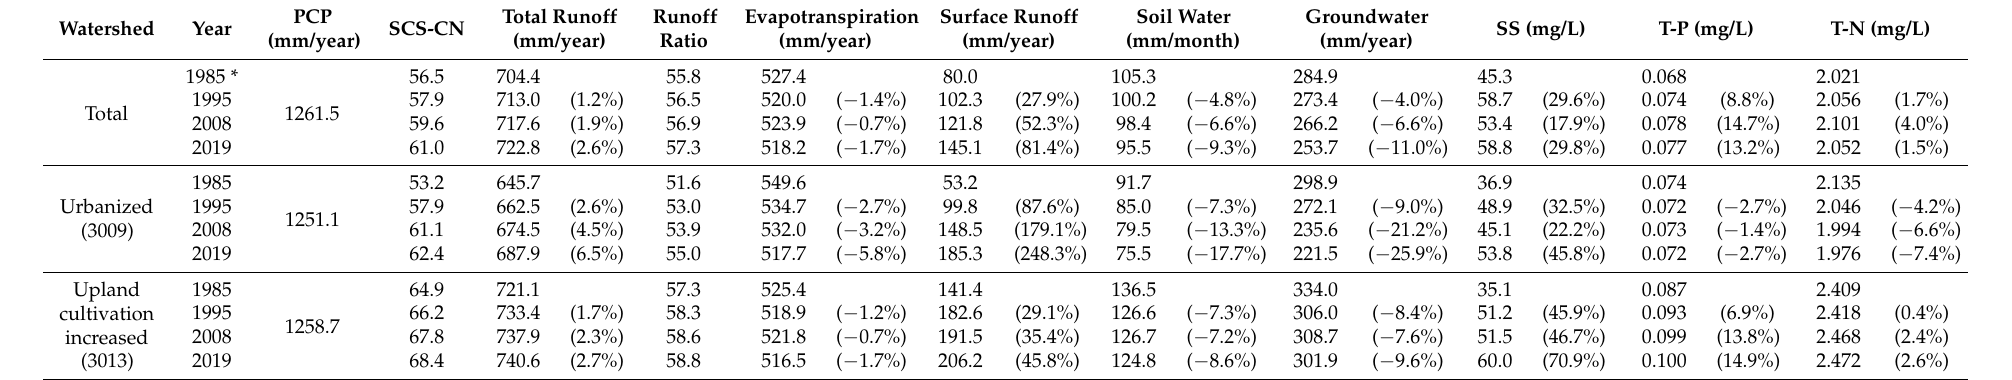
Table 3. The change on hydrology and WQ component